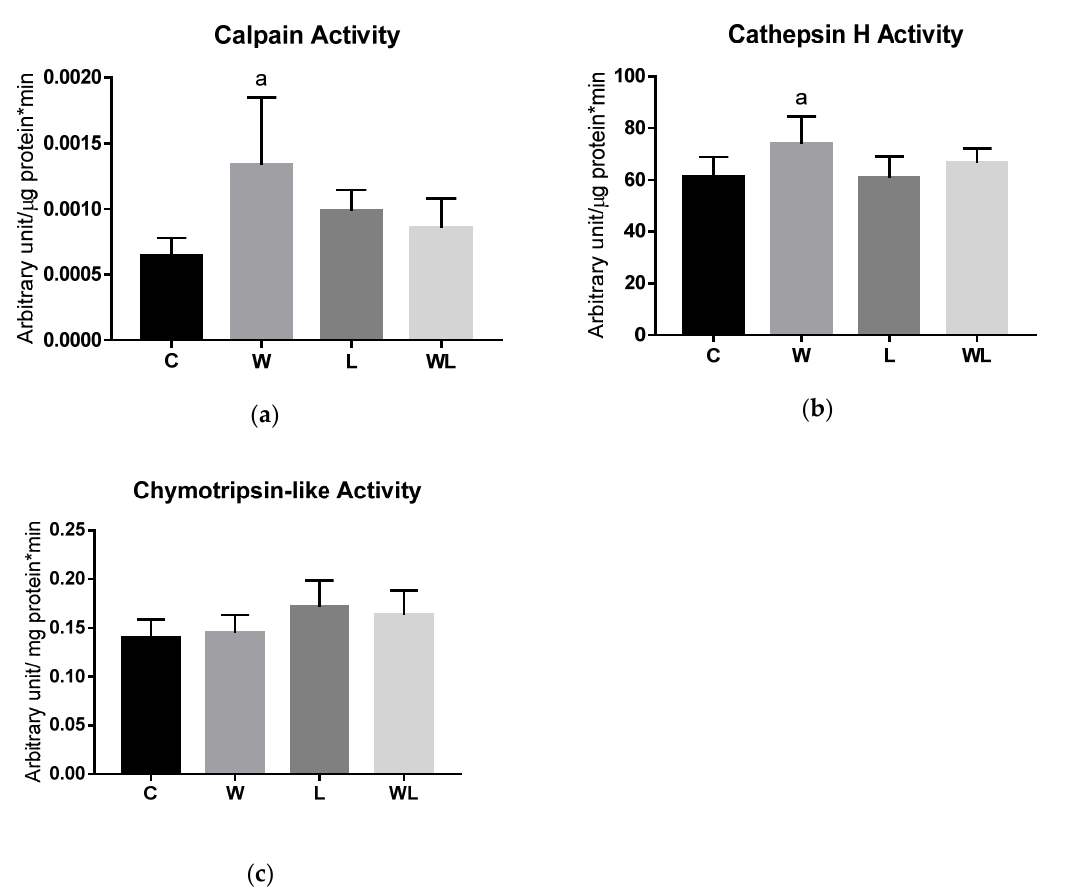
Figure 5. Tumour growth a ff ected the muscle lysosomal and calcium-dependent proteolytic pathways. Enzyme activities related to the following protein degradation pathways were assessed: ( a ) calpain; ( b ) cathepsin H; and ( c ) chymotrypsin-like activities. The results are expressed as arbitrary unit / µ g (or mg) protein*min. C, Control; W, Tumour-bearing animals; L, Control group with a